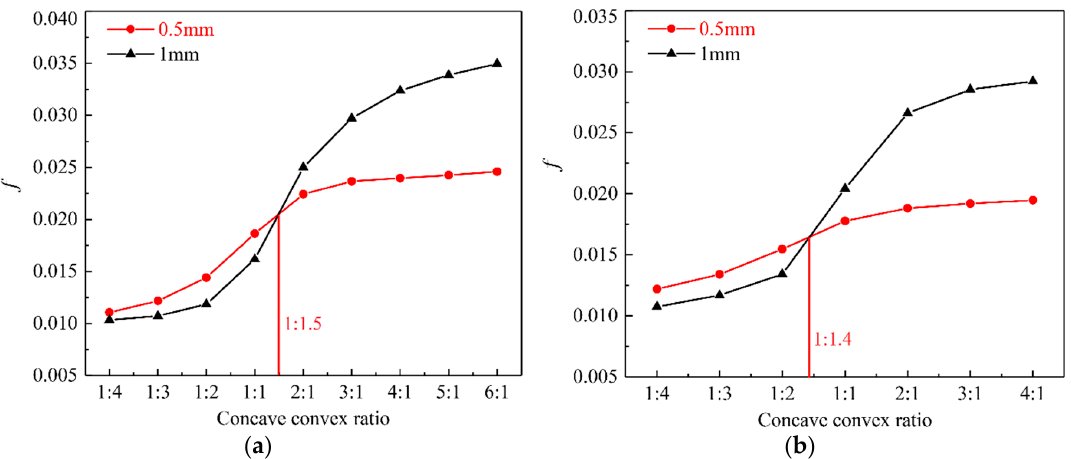
Figure 8. Variation in the friction factor of the narrow channel under different R and H (Re = 3750). ( a ) L u = 6 mm; ( b ) L u = 10 mm.